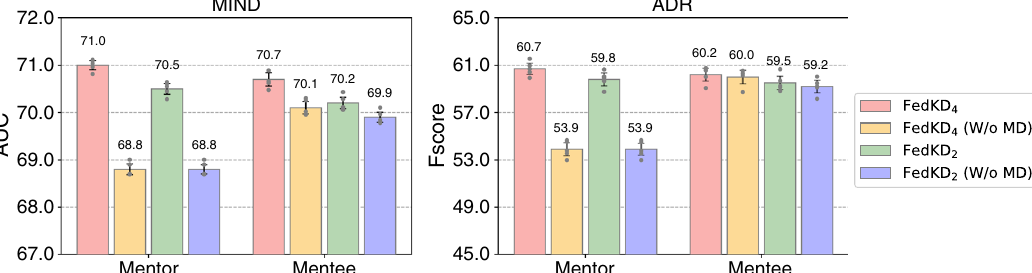
Fig. 2 In fl uence of mutual distillation on the mentee and mentor models. The mean values of AUC scores on MIND and F1 scores on ADR as well as their 95% con fi dence intervals are illustrated ( n = 5 independent experiments). We compare the performance of mentors and the four-layer or two-layer mentee models when mutual distillation (MD) is used or not. The results show that mutual distillation can improve the performance of both mentee and mentor models, which is because useful knowledge can be reciprocally transferred between the mentee and